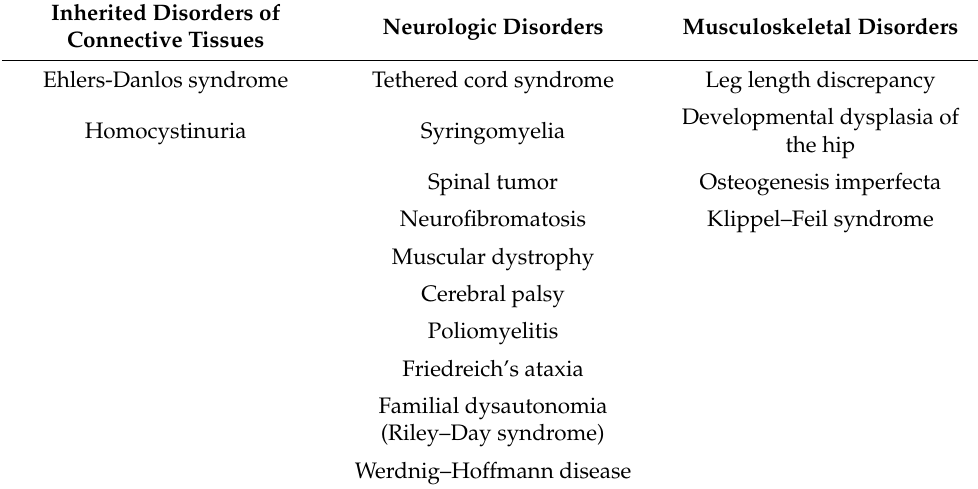
Table 2. Secondary factors leading to scoliosis. Modified from